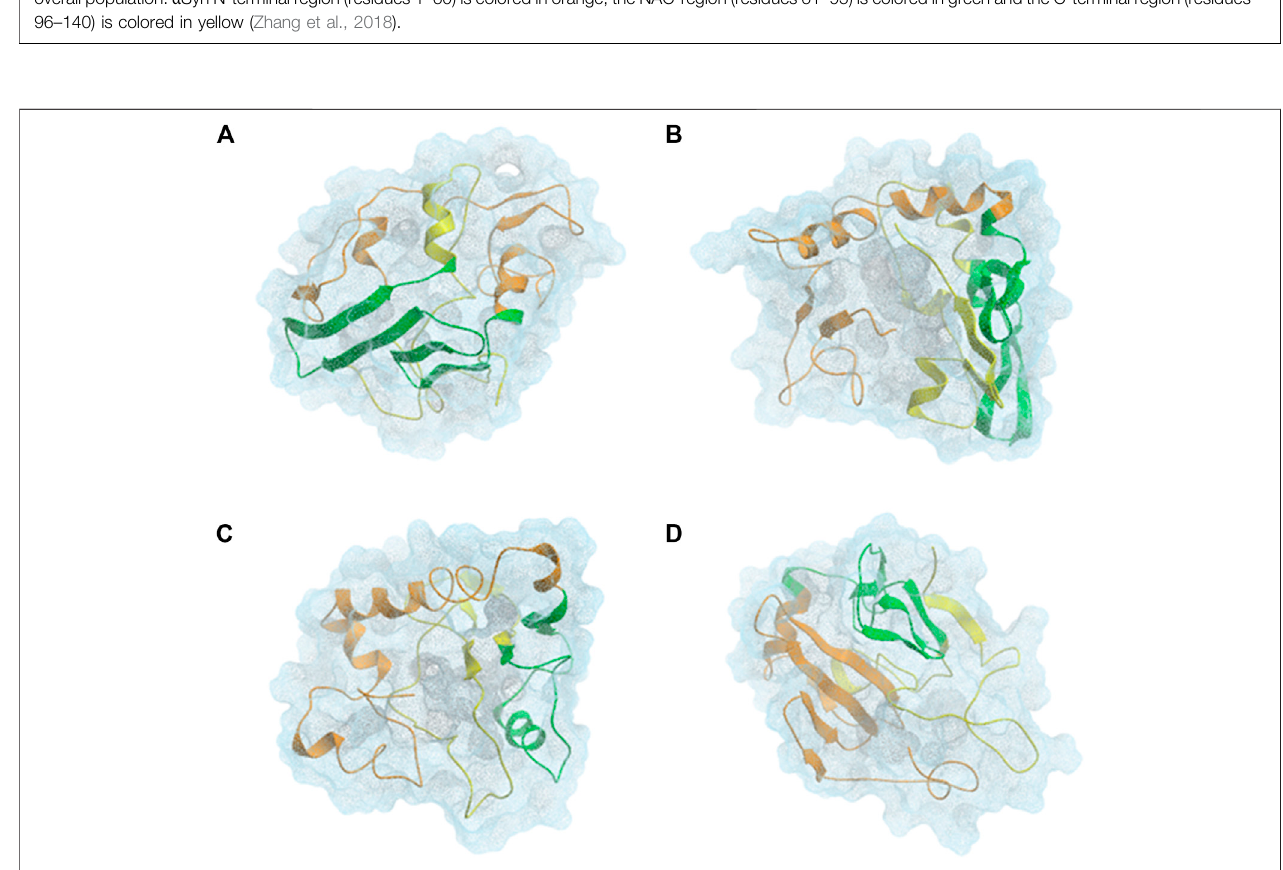
FIGURE3| CL-DMDWTmonomeric α Synmodels.Centroidsfromthemostrelevantconformationalclusterscontaining (A) 37%, (B) 28%, (C) 20%,and (D) 8%of the overall population. α Syn N -terminal region (residues 1 – 60) is colored in orange, the NAC-region (residues 61 – 95) is colored in green and the C -terminal region (residues 96 – 140) is colored in yellow (Brodie et al.,